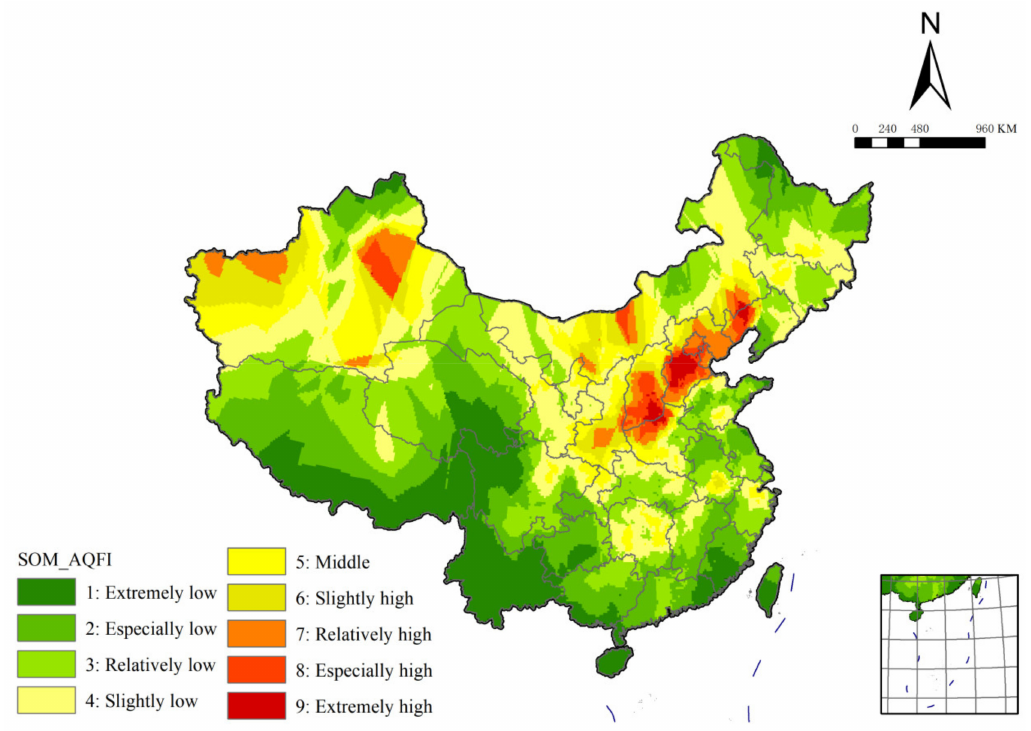
Figure 3. The spatial distribution of SOM